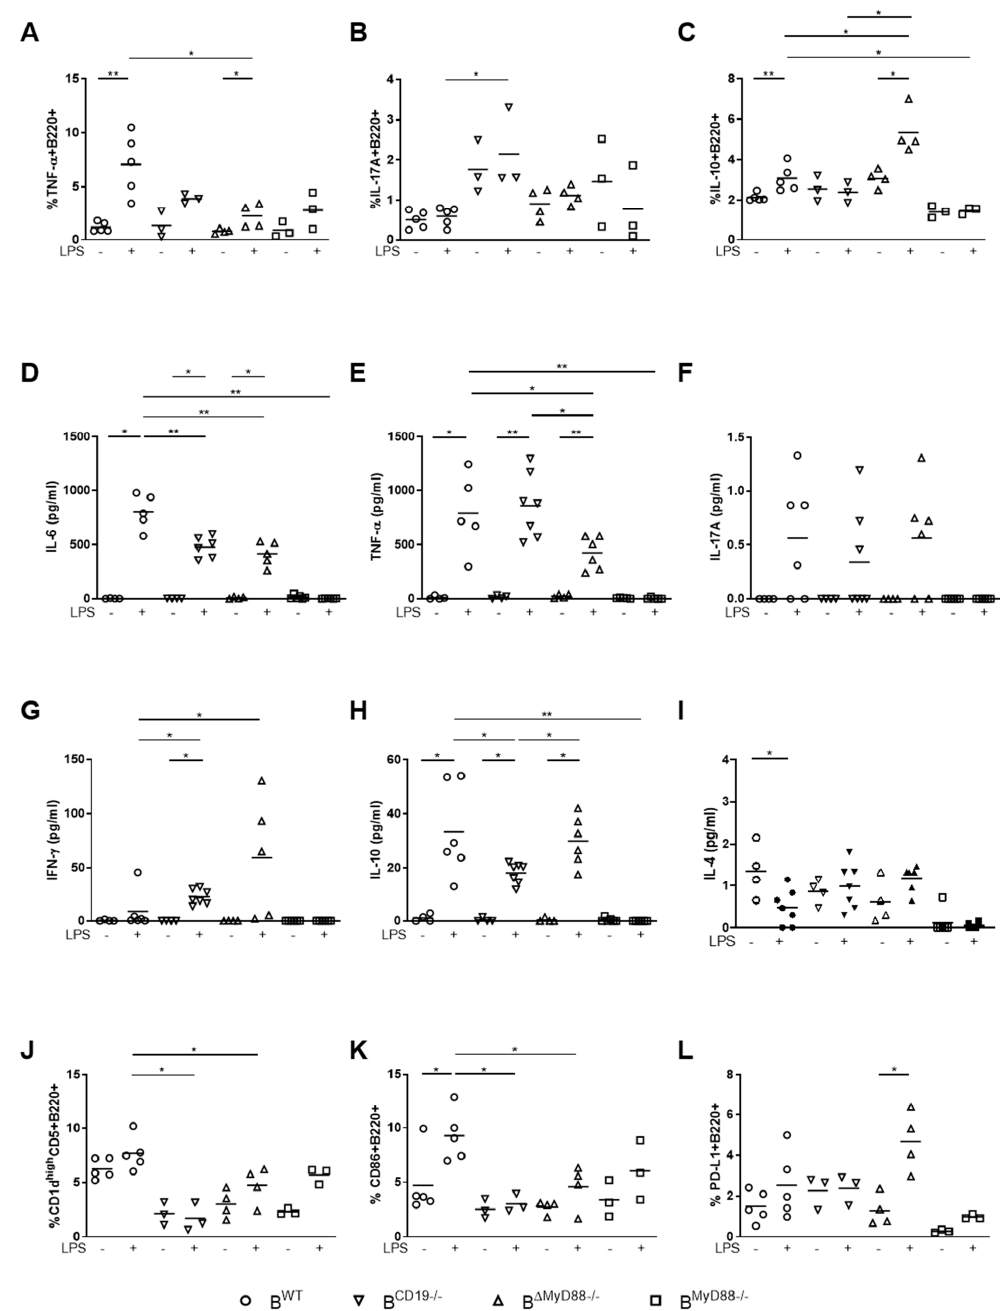
Figure 1. B-cell-specific MyD88 or CD19 knockout influences LPS responsiveness in vitro. Splenic B cells were isolated from pregnant WT (circle), BMyD88 -/- (triangle, point down), CD19 -/- (triangle, point upwards) and MyD88 -/- mice (square) at gestational day (gd) 10 and incubated with Brefeldin A (control) or Brefeldin A, LPS, PMA and ionomycin for 5 h. The frequencies of TNF- α + B220 + B cells ( A ), IL-17A + B220 + B cells ( B ) and IL-10 + B220 + B cells ( C ) were analyzed by flow cytometry. The levels of IL-6 ( D ), TNF- α ( E ), IL-17A ( F ), IFN- γ ( G ), IL-10 ( H ) and IL-4 ( I ) produced by B cells from WT, BMyD88 -/- , CD19 -/- or MyD88 -/- mice following 24 h of LPS stimulation or medium control incubation were determined by CBArray. The percentages of CD1d high CD5 + B220 + B cells ( J ), CD86 + B220 + B cells ( K ) and PD-L1 + B220 + B cells ( L ) were determined by flow cytometry following 5 h incubation with either Brefeldin A (control) or Brefeldin A, LPS, PMA and ionomycin. The Kruskal–Wallis test and Mann–Whitney U test were used to analyze the data. N = 3–8 mice/group; * p < 0.05, ** p < 0.01. Shown are the mean